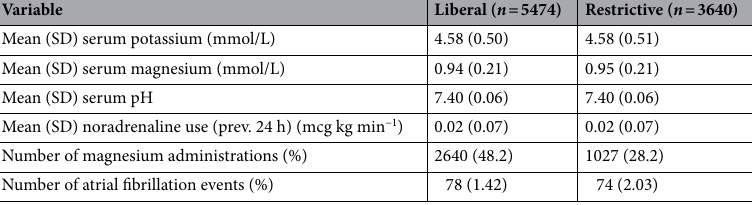
Table 3. Observation window characteristics of liberal and restrictive magnesium supplementation groups.